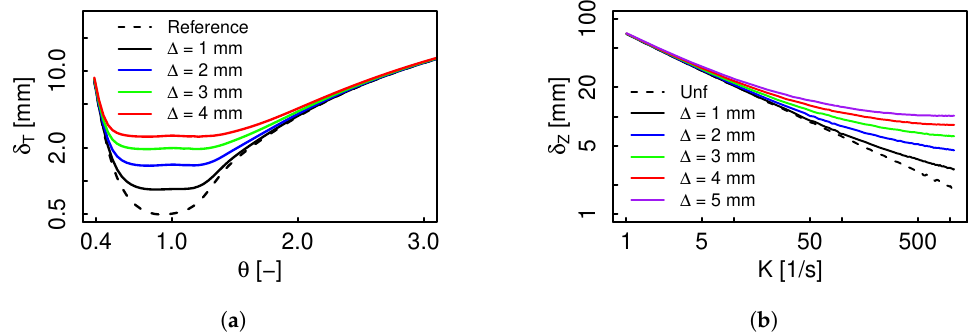
Figure 1. Flame thickness along a ( a ) premixed and ( b ) non-premixed CH 4 –air manifold as a function of the equivalence ratio θ and the strain rate K , respectively, for different filter